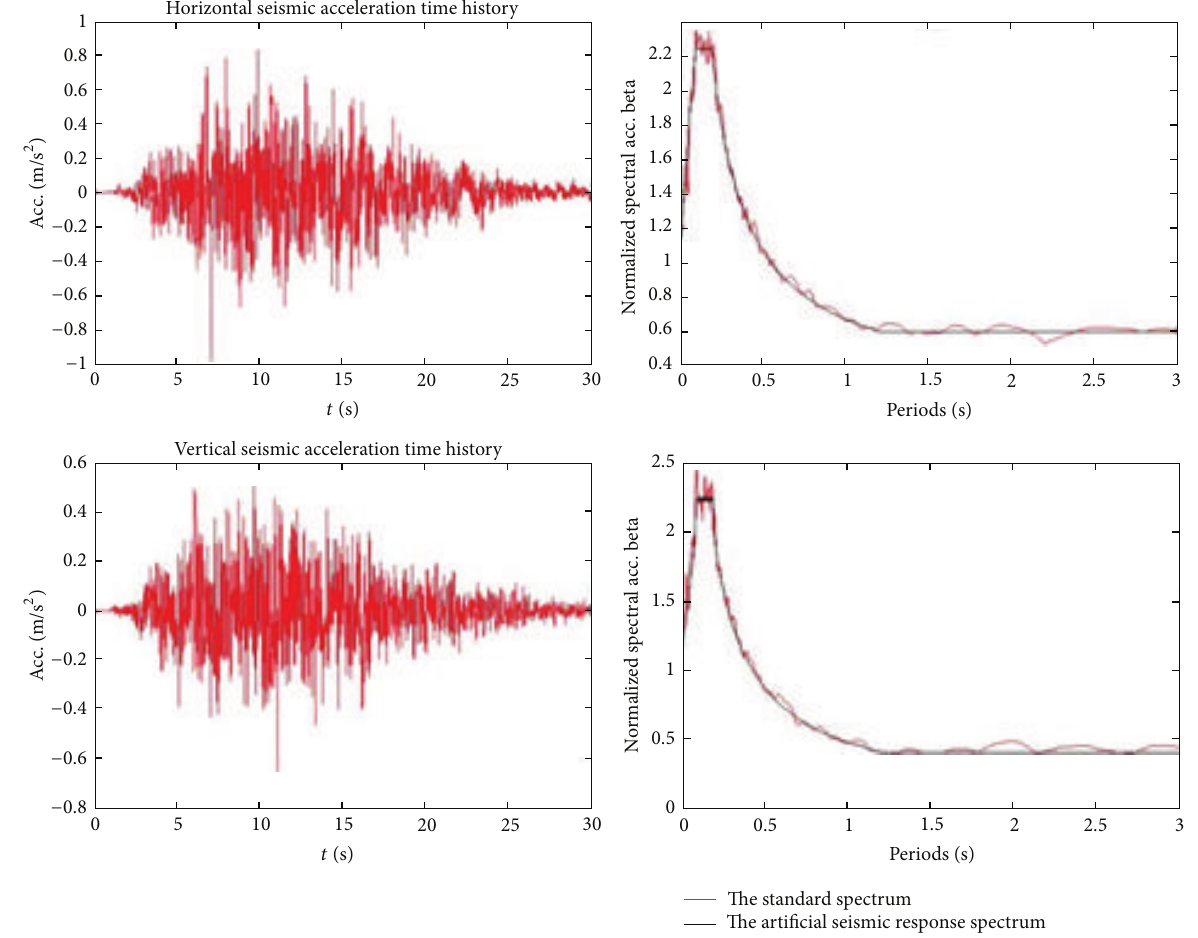
Figure 3: Inversed seismic waves and the response spectrum.